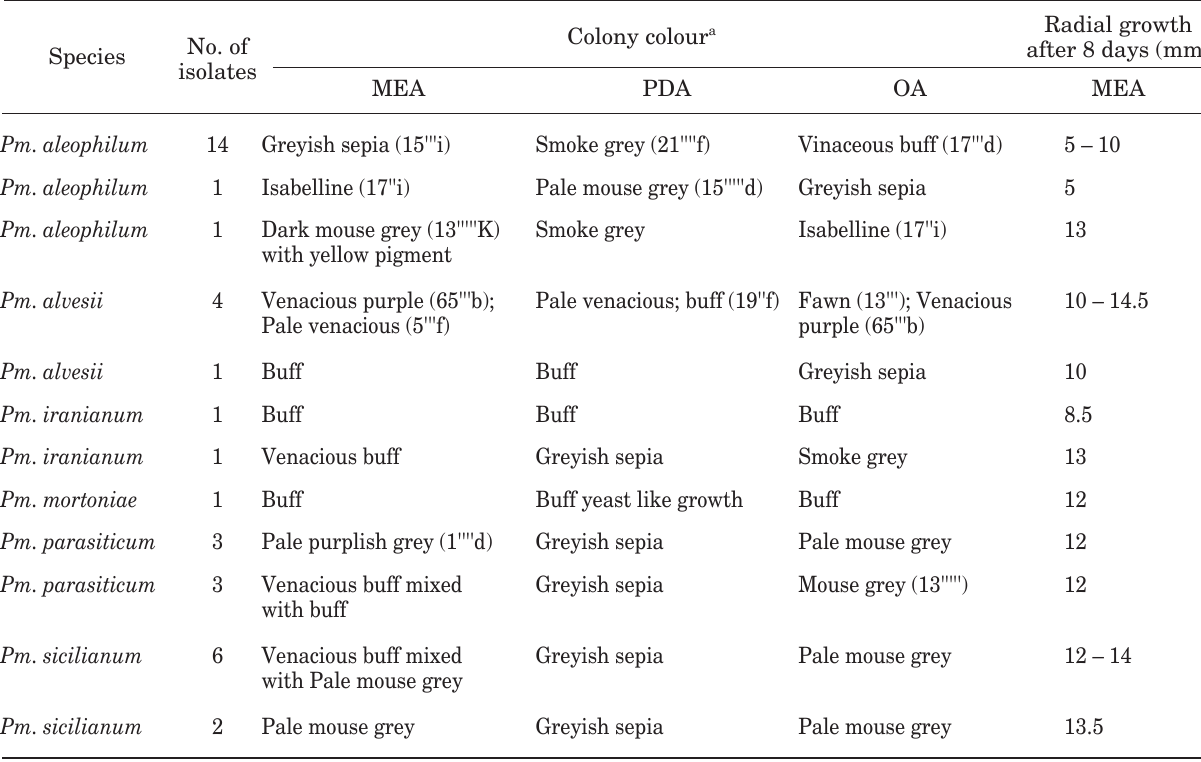
Table 2. Cultural growth characteristics of Phaeoacremonium isolates grown on malt extract agar (MEA), potato dextrose agar (PDA) and oatmeal agar